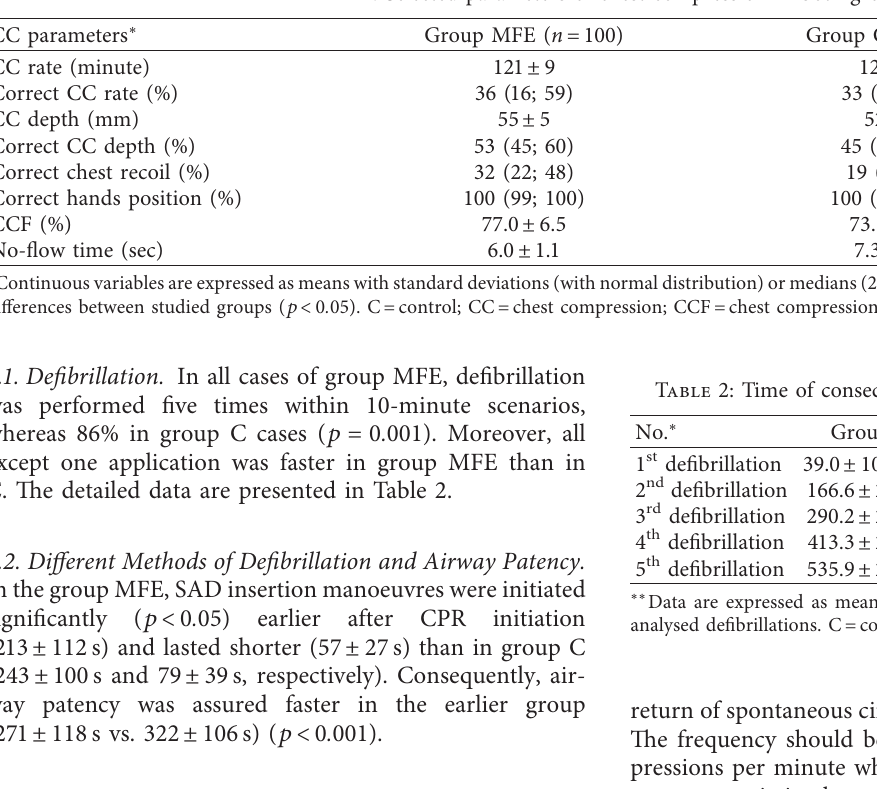
Table 1: Selected parameters of chest compression in both groups.